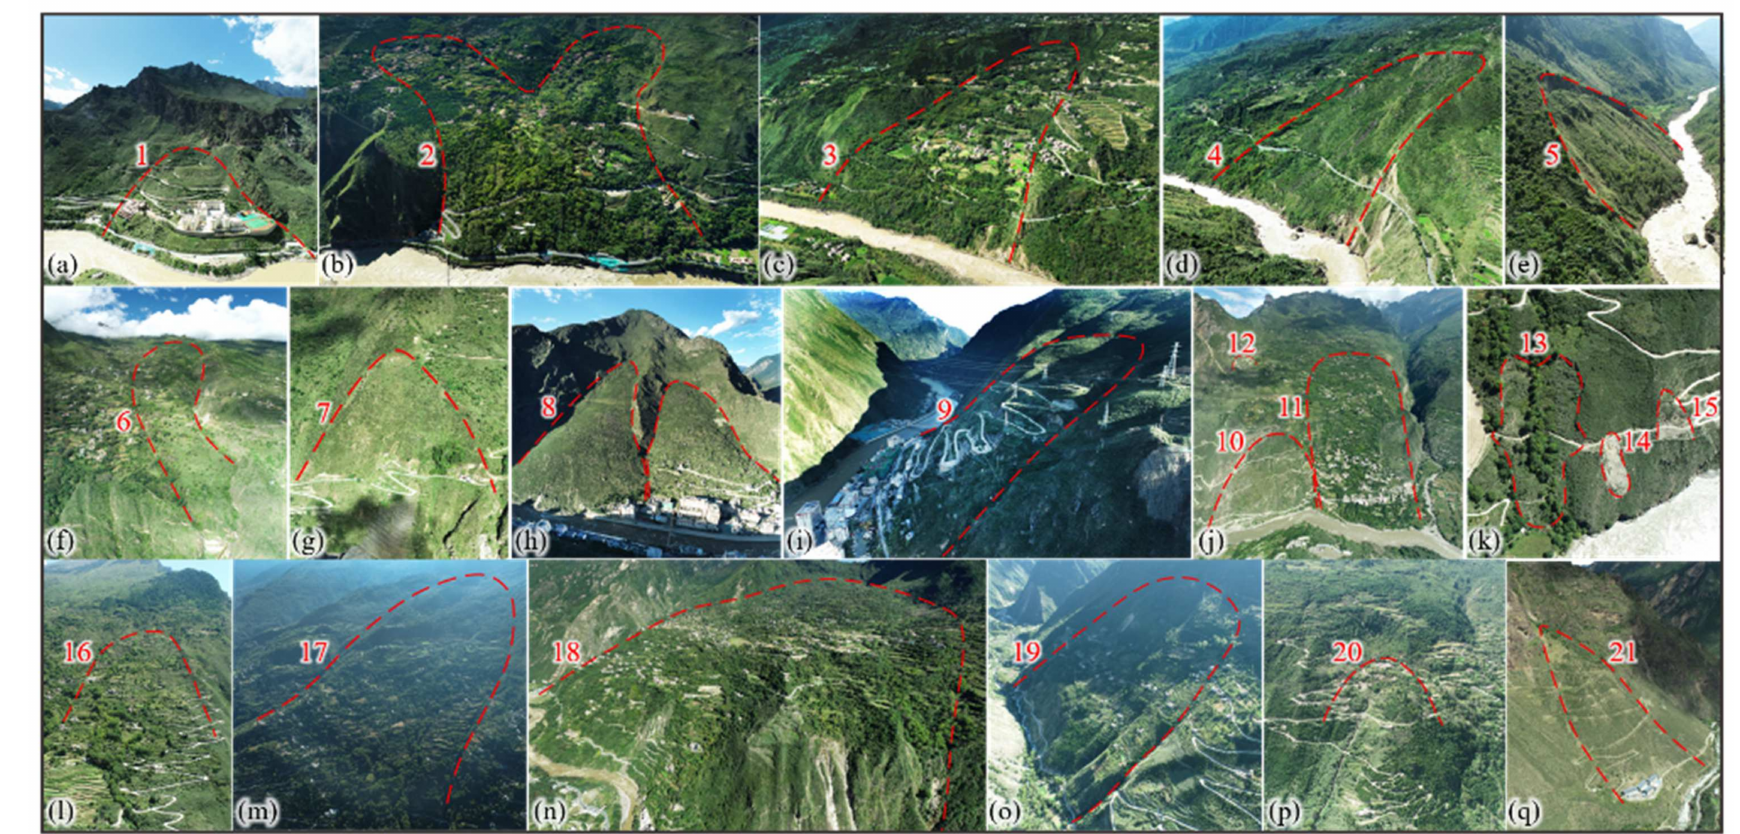
Figure 10. Panoramic views of the real landslides taken by the Unmanned Aerial Vehicle (UAV): Landslide Nos. 1–21 ( a – q